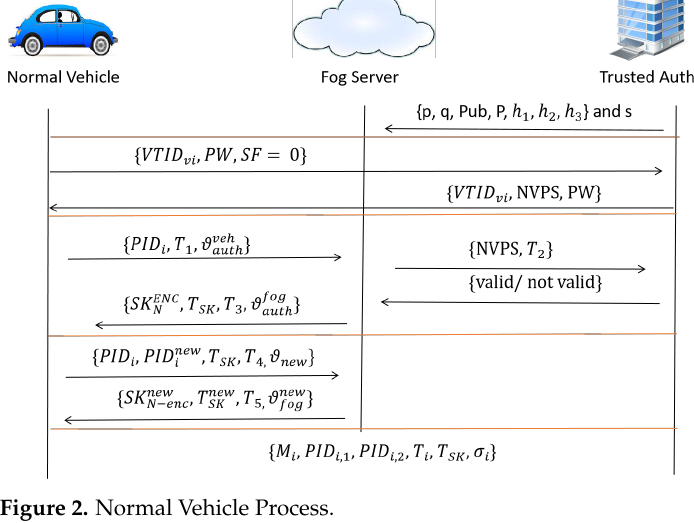
Figure 2. Normal Vehicle Process.